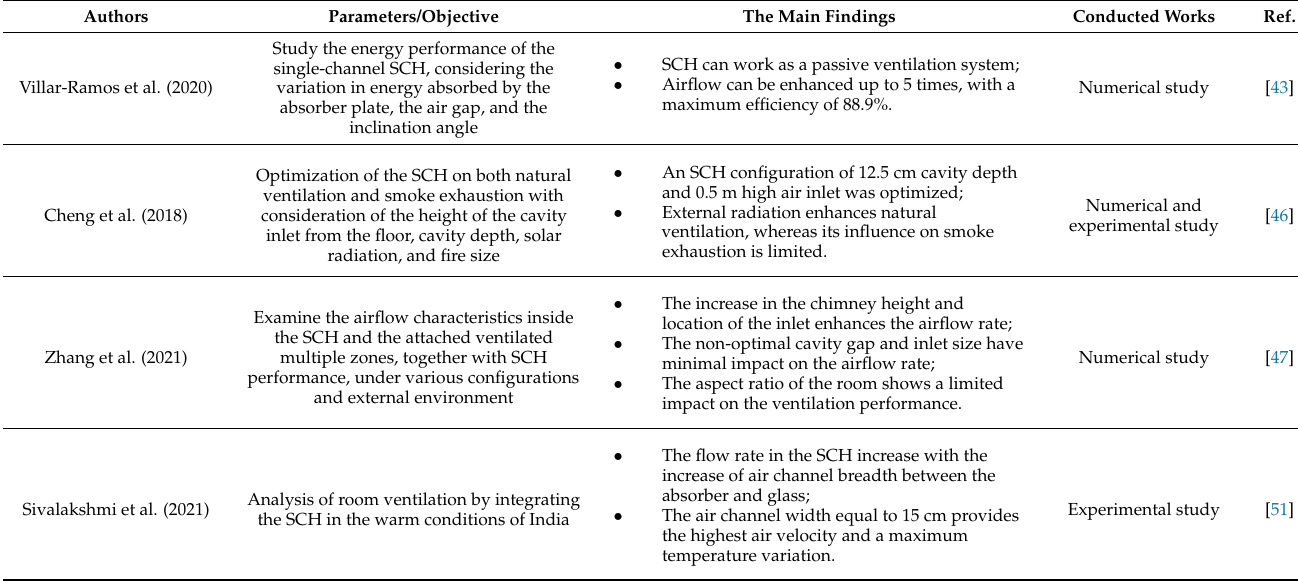
Table 1. The summary of works focused on solar